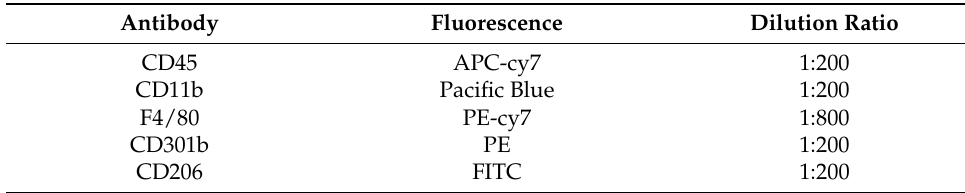
Table 1. Flow cytometry color